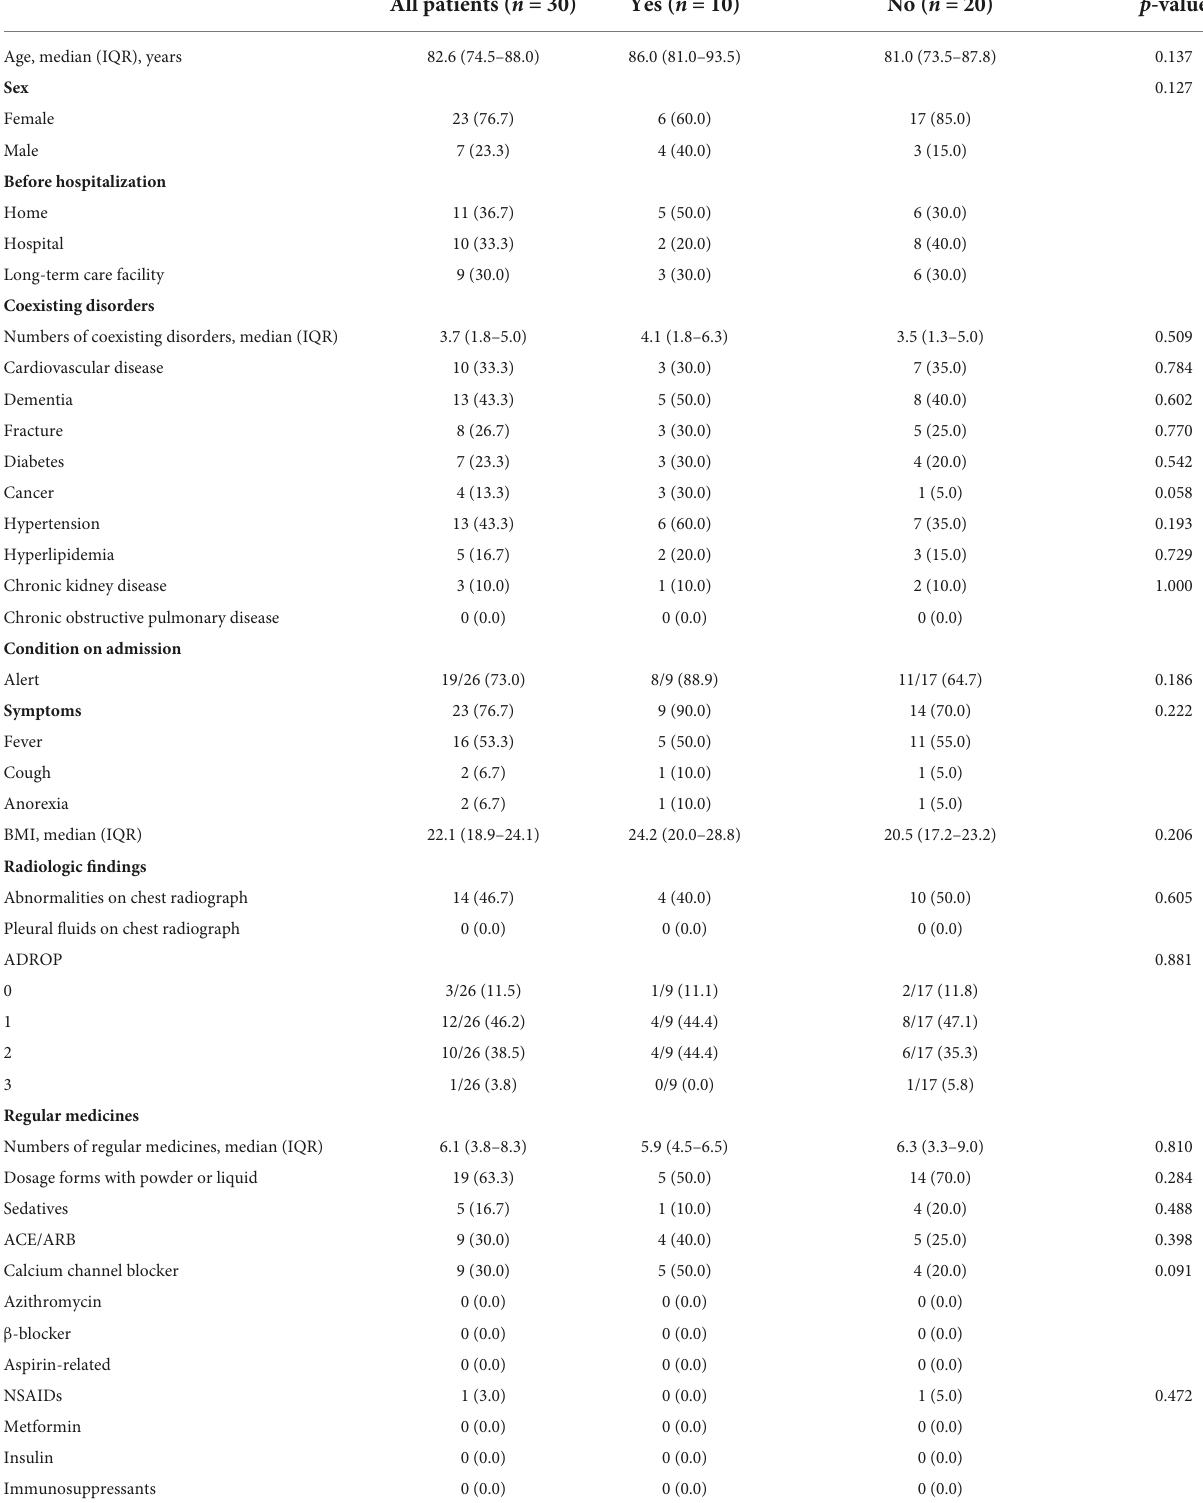
TABLE 1 Clinical characteristics of patients with COVID-19 based on local non-image